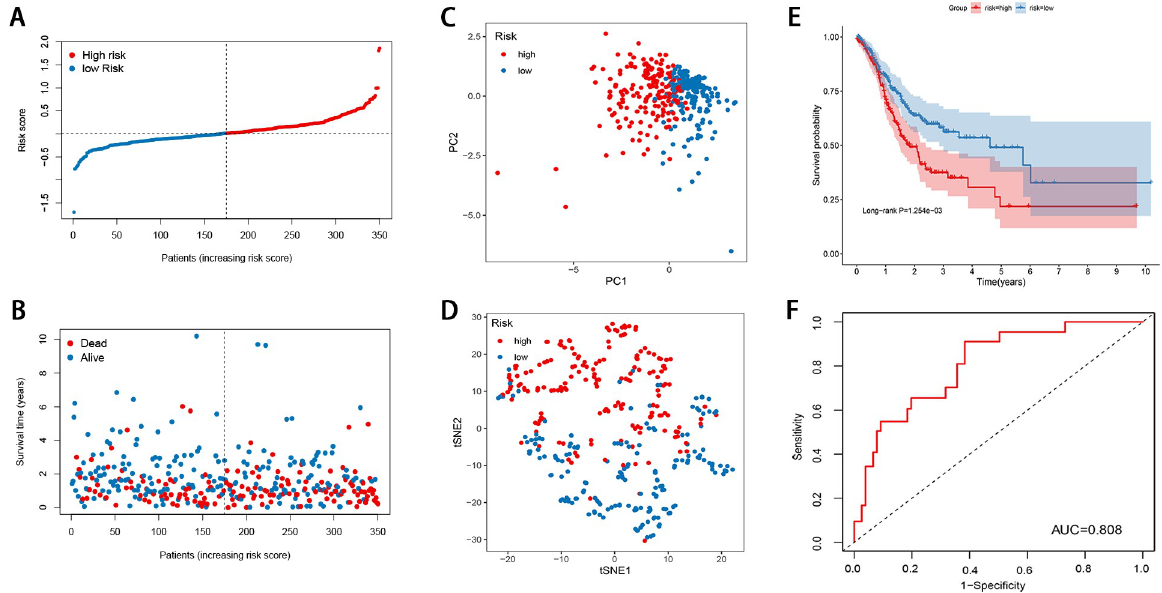
Fig 2. Construction of the ferroptosis-related gene signature in the training cohort (A) Risk score distribution (B) Overall survival time of GC patients (C) PCA plot (D) t-SNE analysis (E) Kaplan-Meier curves for the OS of patients in the high-risk group and low-risk group (F) ROC curve for the prediction of GC survival.